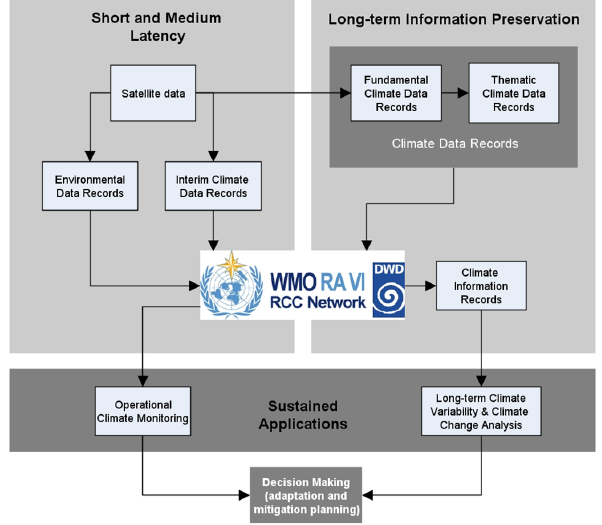
Figure 1. Sustained climate information flow and the interfaces with RCC-CM. Figure adapted and modified from Dowell et al. (2013, Fig. 6.2) and WMO (2012, Fig.